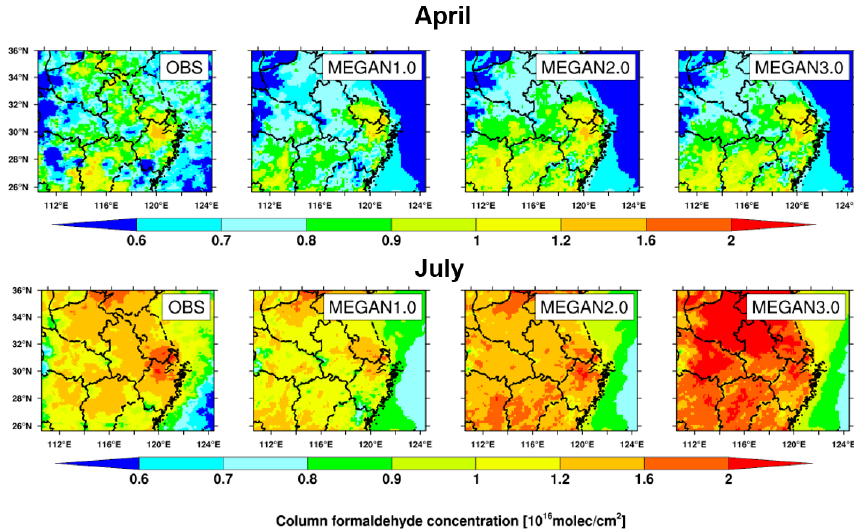
Figure 10. Spatial distributions of total column tropospheric formaldehyde concentration (include biogenic and anthropogenic emissions) in April and July with different versions of MEGAN using the VEG-2015 vegetation dataset. The first column is from the satellite